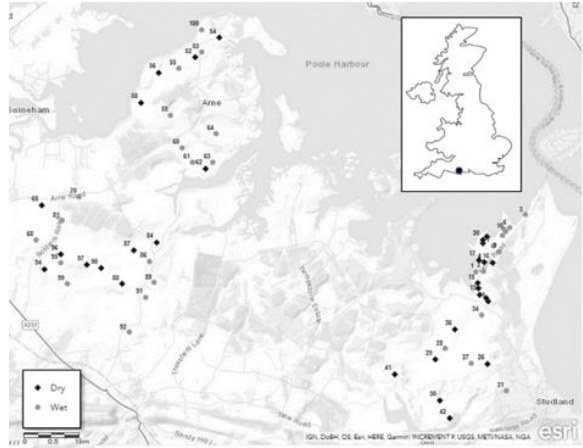
F IGURE 1. Locations of wet and dry heath field sites (grey circles wet sites and black diamonds dry sites) with an inset map identifying the location of the sites within the UK (Grid references in